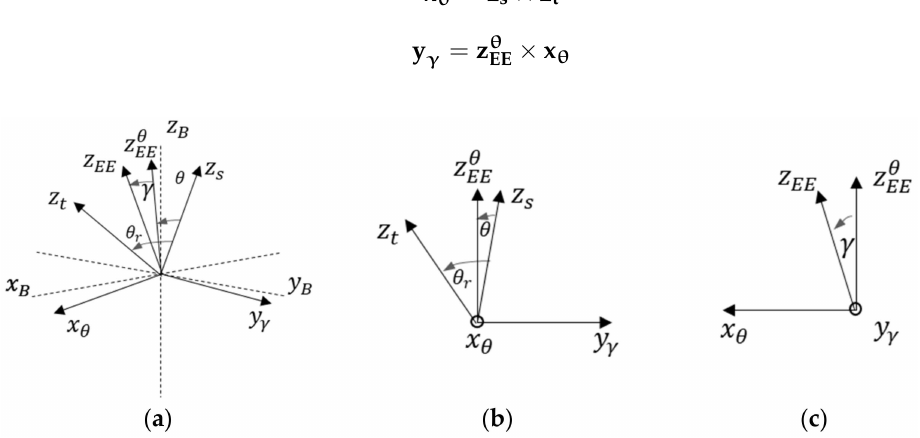
Figure 2. ( a ) Schematic representation of the z-axis overlapping motion for reaching the vector z t starting from z s . The angles θ and γ are defined relative to the rotation axis x θ and y γ . ( b ) Section of the plane defined by the vectors z t and z s spanned by the θ angle. ( c ) Section of the plane spanned by the γ angle perpendicular to the x θ and z θ EE